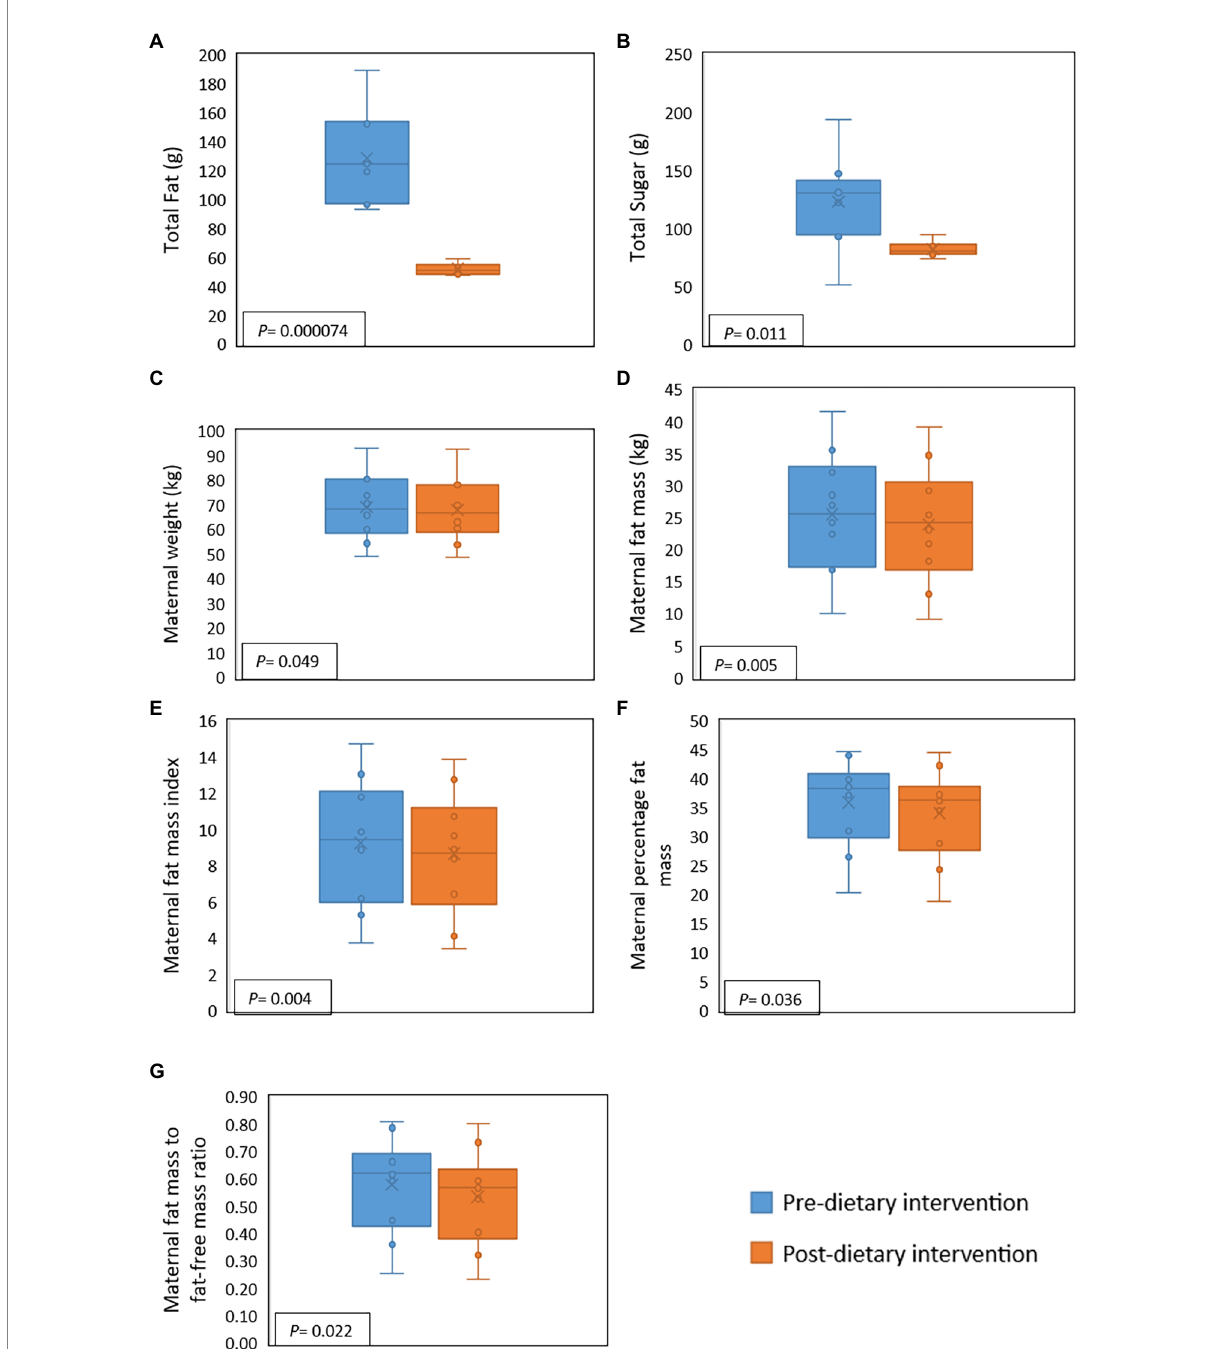
FIGURE 2 Effect of a 2-week maternal dietary intervention on maternal dietary intakes and body composition. Total maternal fat intake (A) and total maternal sugar intake (B) were significantly reduced by the dietary intervention. Maternal weight (C) , fat mass (D) , fat mass index (E) , percentage of fat (F) , and fat mass to fat-free mass ratio (G) were also significantly decreased after the dietary intervention. X represents the mean value, while the solid line represents the